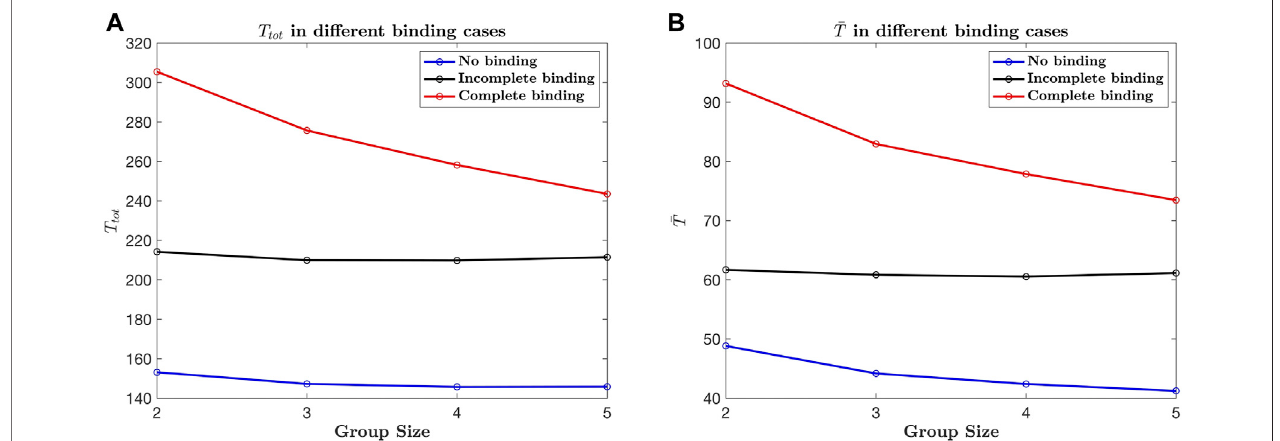
Frontiers in Physics |